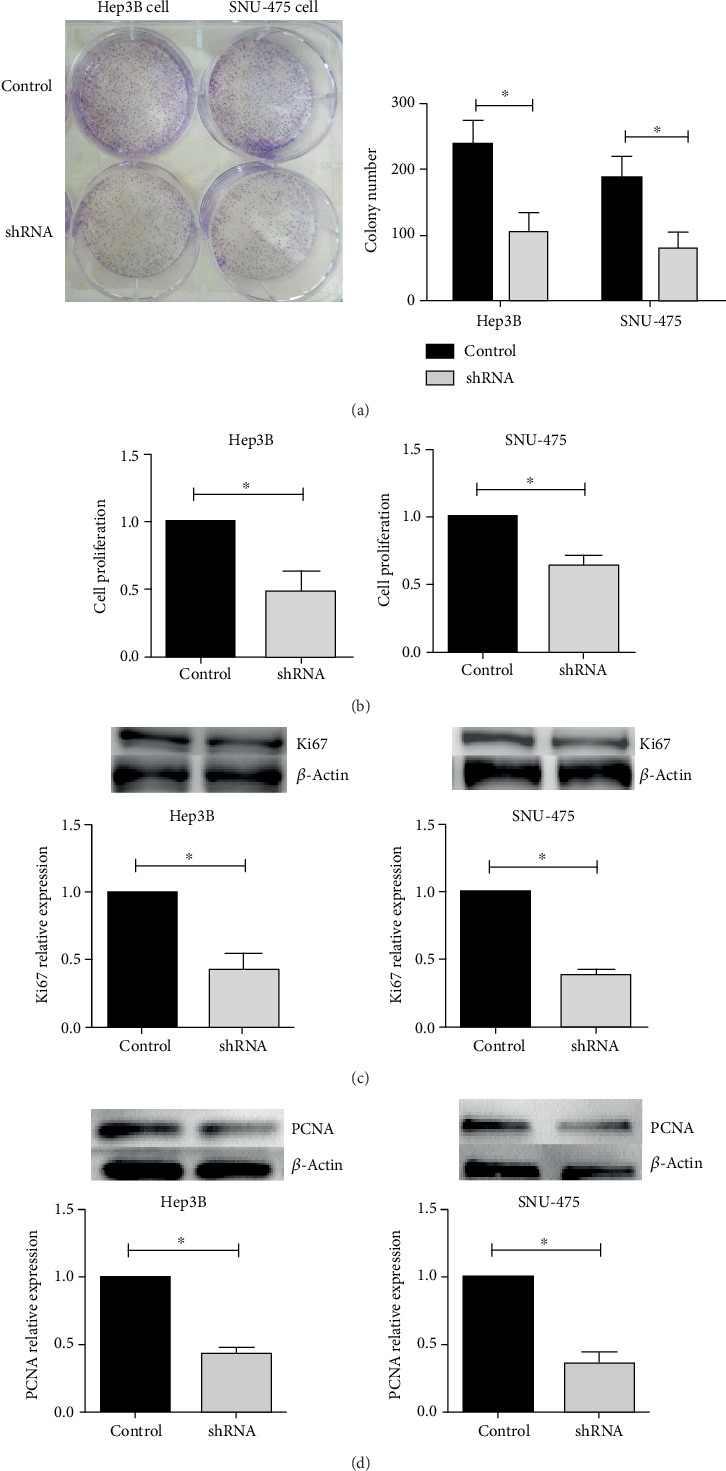
KIF15 promotes HCC cell proliferation in vitro. (a) Hep3B and SNU-475 cells transfected with control or KIF15 shRNA, and the proliferation capacity was quantified by colony formation assays. (b) The results of MTT assays showed the inhibition of cell proliferation caused by KIF15 depletion. (c) Immunoblot assays showed Ki67 expression level in control or KIF15 knockdown Hep3B and SNU-475 cells. (d) The results of immunoblot assays revealed the expression level of PCNA in control or KIF15 ablation HCC cells. Results are presented as mean ± SD, ∗P < 0.05.